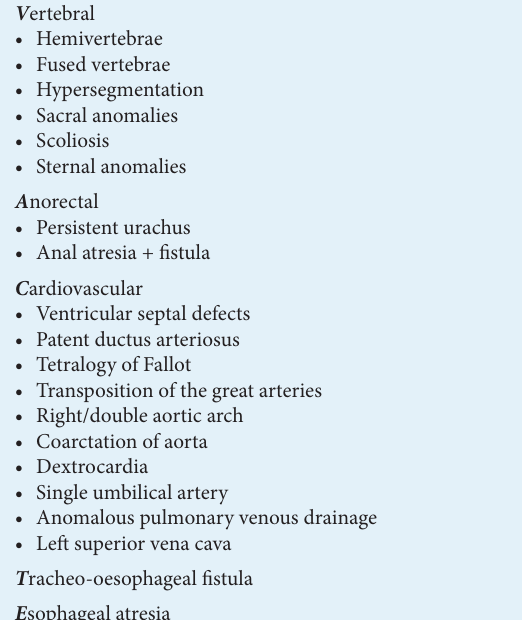
Table 1. Spectrum of systemic associations related to VACTERL